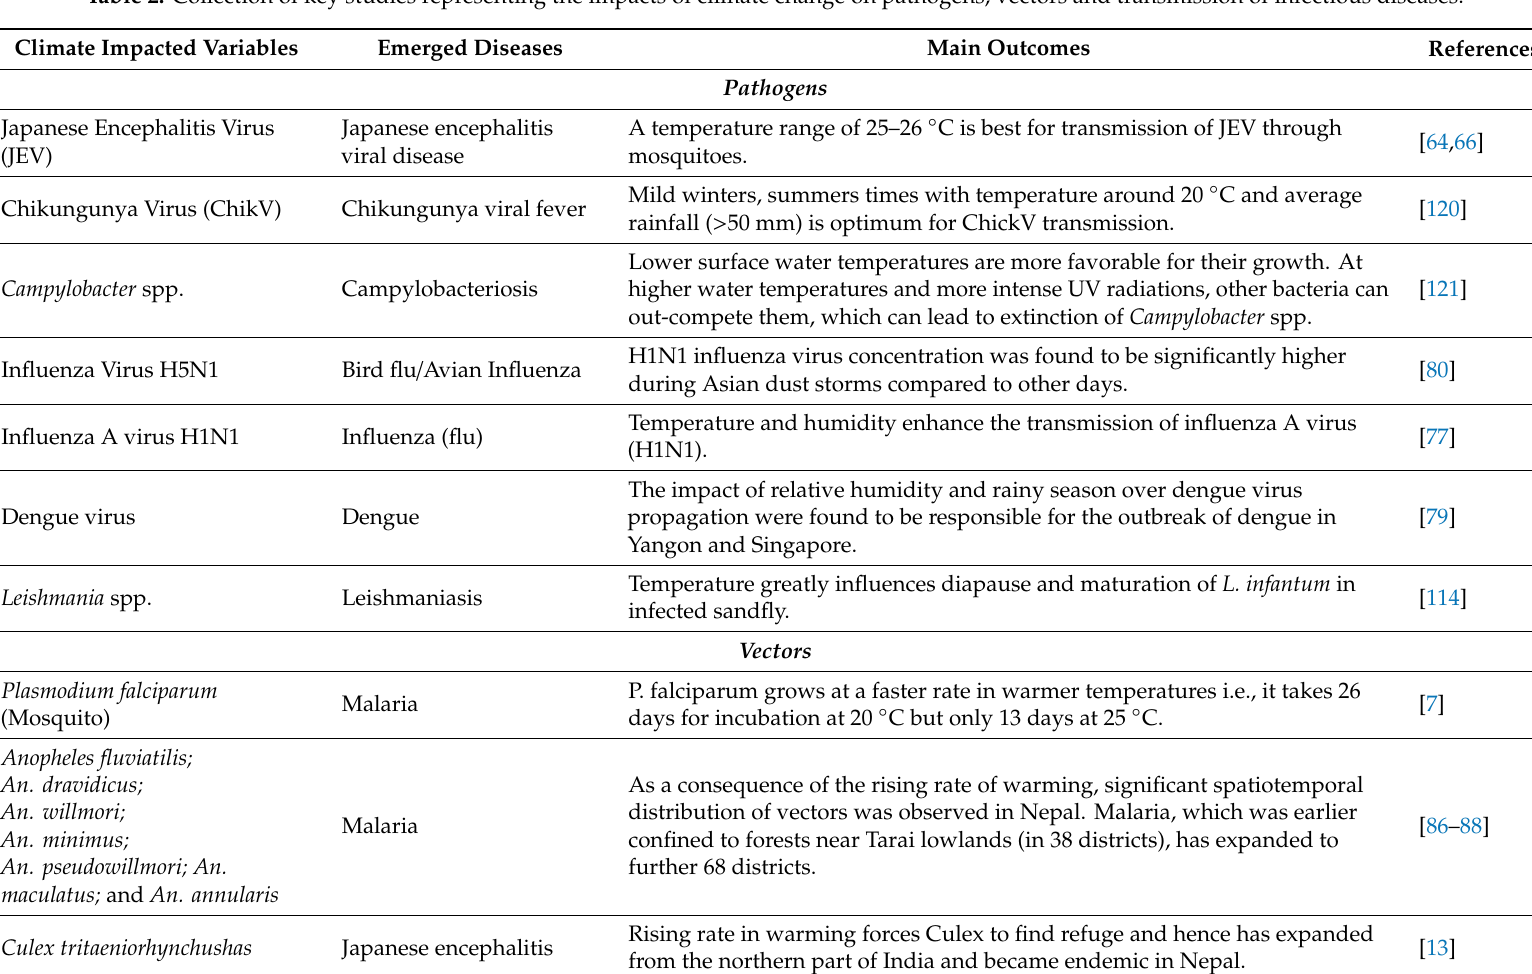
Table 2. Collection of key studies representing the impacts of climate change on pathogens, vectors and transmission of infectious